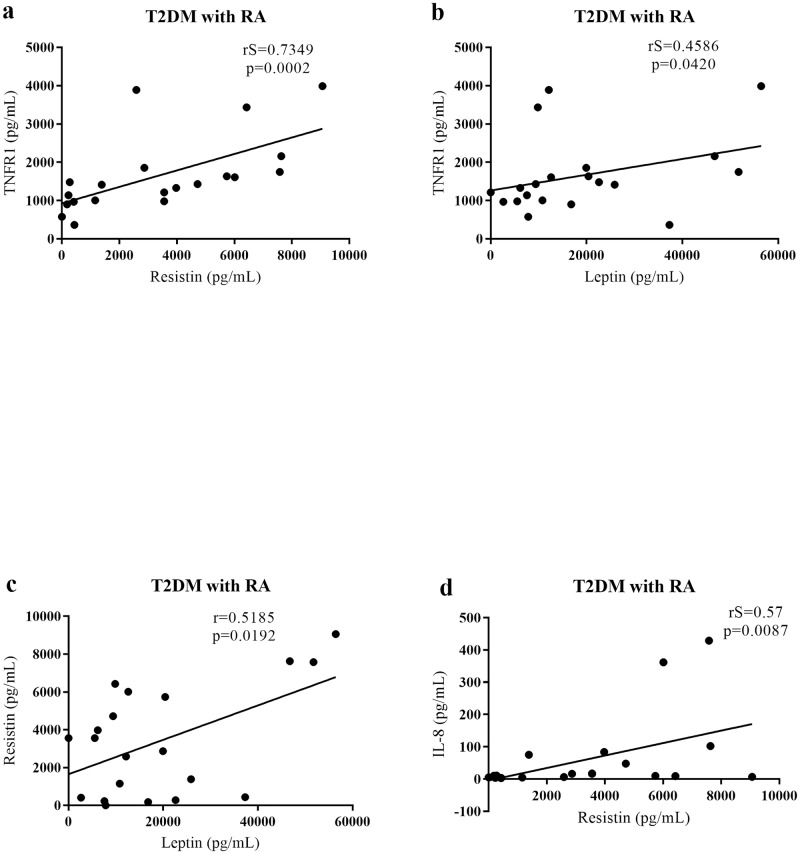
Correlations between serum cytokine and adipokine levels in patients with T2DM with RA.(a) Positive and significant correlation between TNFR1 and resistin levels, (b) between TNFR1 and leptin levels, (c) between resistin and leptin levels, (d) between resistin and IL-8 levels in patients with T2DM with RA. RA, renal alteration.